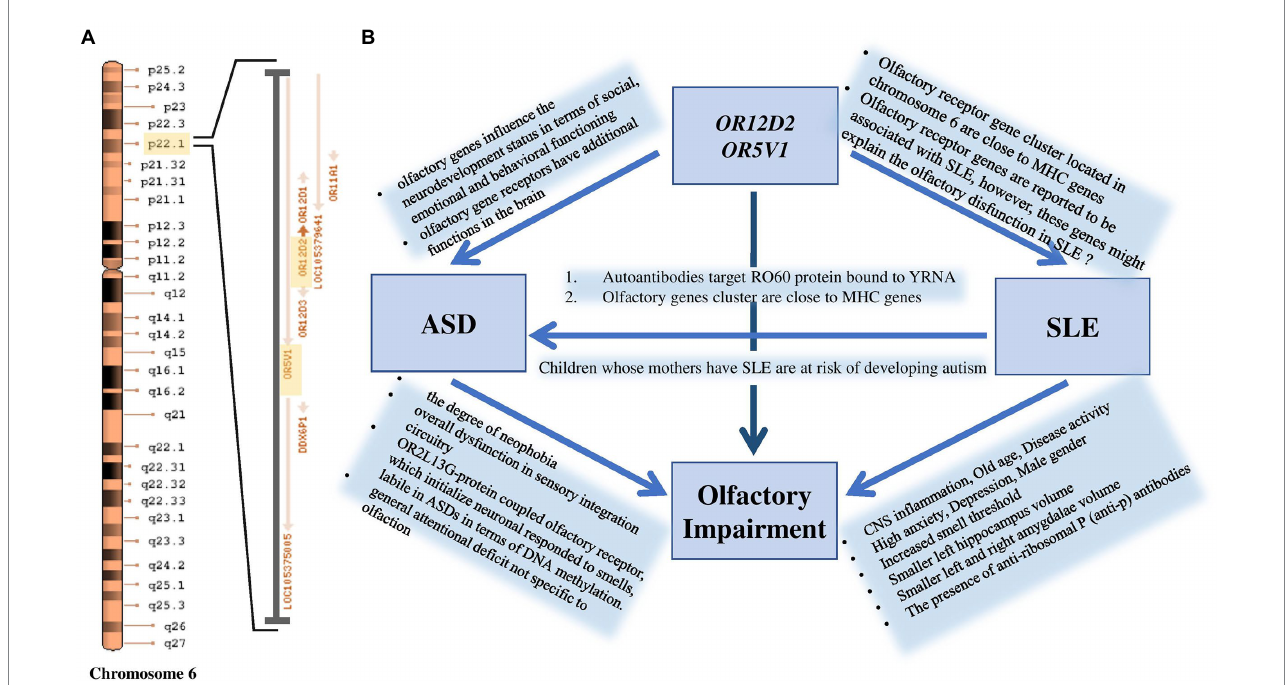
FIGURE 5 (A) Significant ASD variation at OR12D2 and OR5V1 genes are located within a cluster of olfactory receptor genes at the chromosomal region 6p22.1. (B) The figure shows that maternal SLE influences the manifestation of ASD in their offspring. Smell deficits and variations in olfactory receptor genes, particularly in OR12D2 and OR5V1 , are common in both ASD and SLE